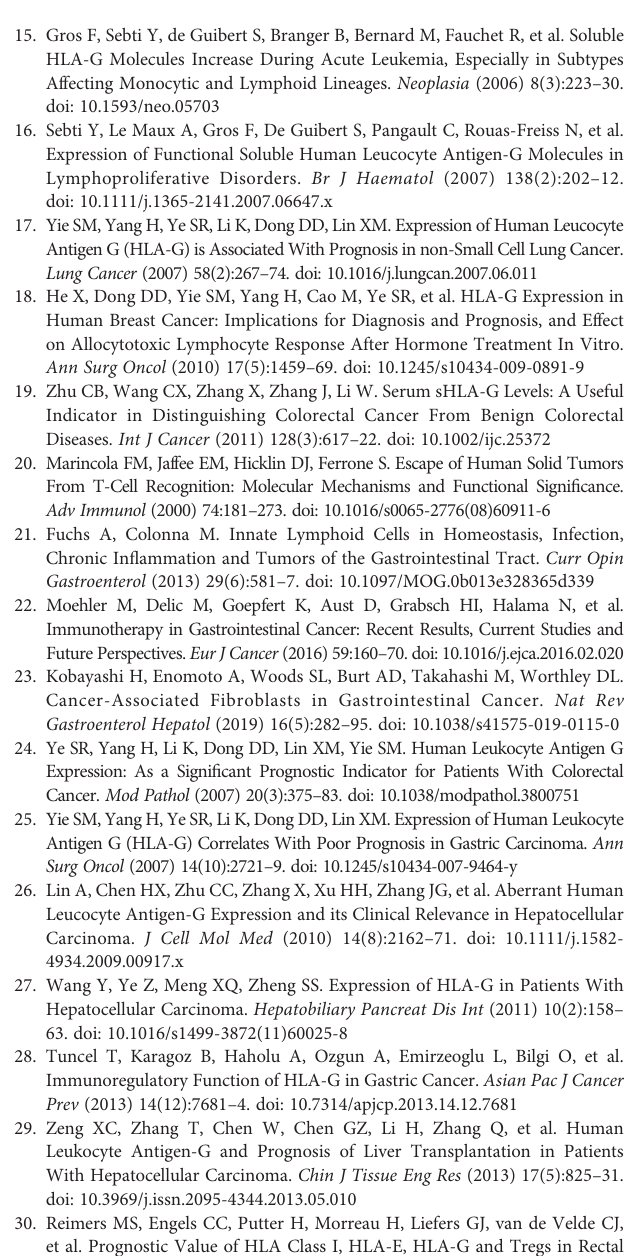
Supplementary Figure 4 | Sensitivity of all outcomes. (A) positive vs. negative HLA-G expression (univariate analysis), (B) positive vs. negative HLA-G expression (multivariate analysis), (C) strong vs. weak HLA-G expression (univariate analysis), (D) strong vs. weak HLA-G expression (multivariate analysis), (E) clinical stage, (F) tumor status, (G) nodal status, (H) metastasis, (I) histological grade. Supplementary Figure 5 | Trim and fi ll of all outcomes. (A) positive vs. negative HLA-G expression (univariate analysis), (B) positive vs. negative HLA-G expression (multivariate analysis), (C) clinical stage, (D) tumor status, (E) nodal status, (F) metastasis, (G) histological